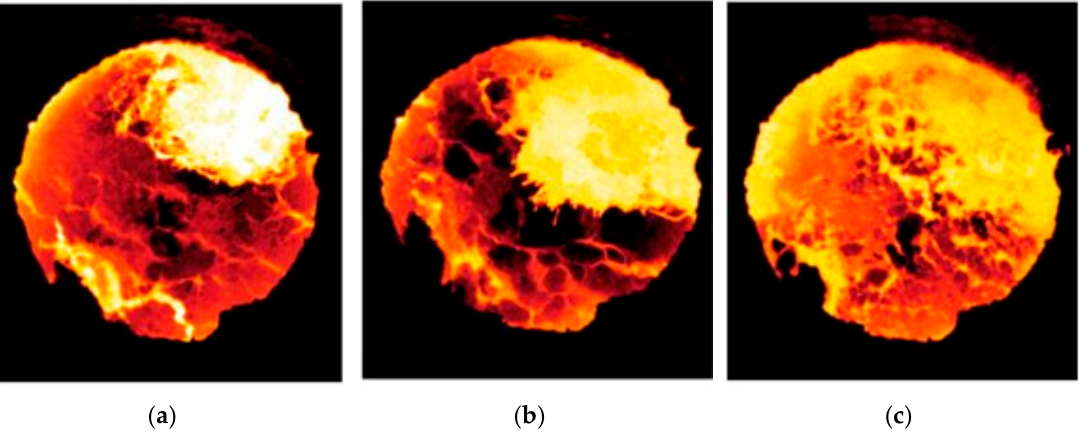
Figure 12. Open-eye size in the ladle from experimental results for a slag layer thickness of 25 cm: ( a ) Q = 200 NL/min, ( b ) Q = 400 NL/min, and ( c ) Q = 500 NL/min.